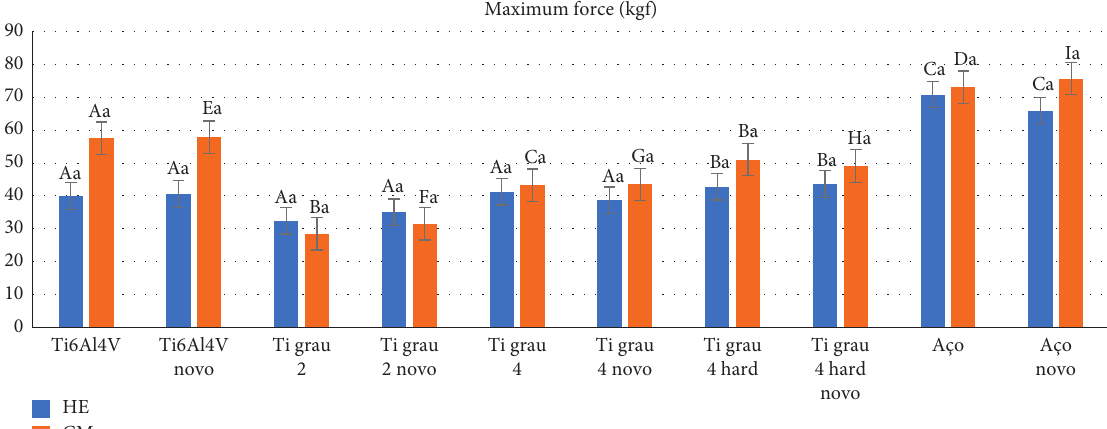
Figure 9: Graphical representation of the means and standard deviations for maximum force (kgf) as a function of alloy type for HE and MT connections.